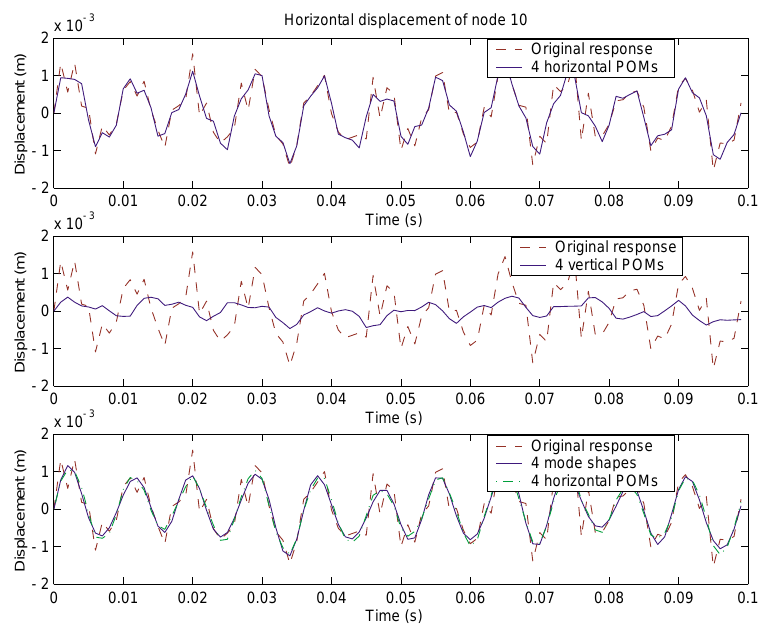
Fig. 7. KL and mode shape reconstruction for an horizontal impulse applied at node 10.